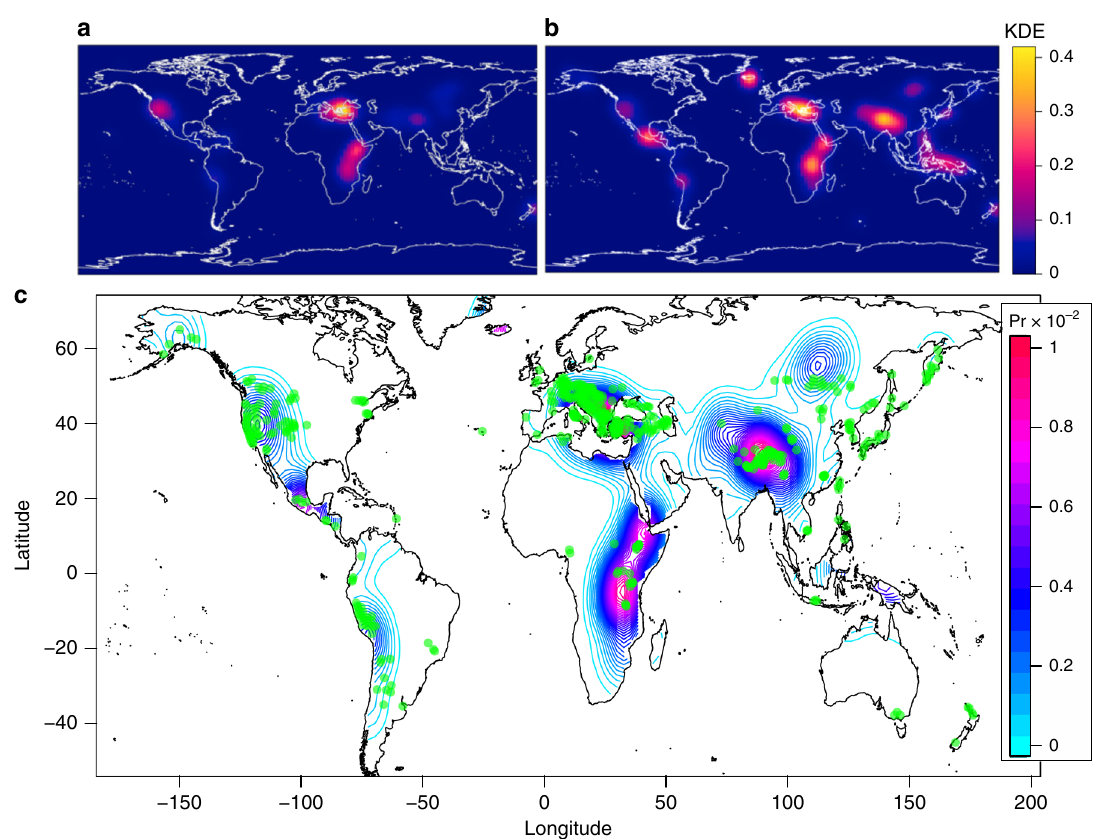
Fig. 4 Probability of extensional tectonic and earth degassing. Estimated kernel densities for extensional faults ( a ) and earthquakes ( b ) used to obtain the probability of occurrence of tectonic gas discharges ( c ). Green dots are the existing gas discharges listed in this